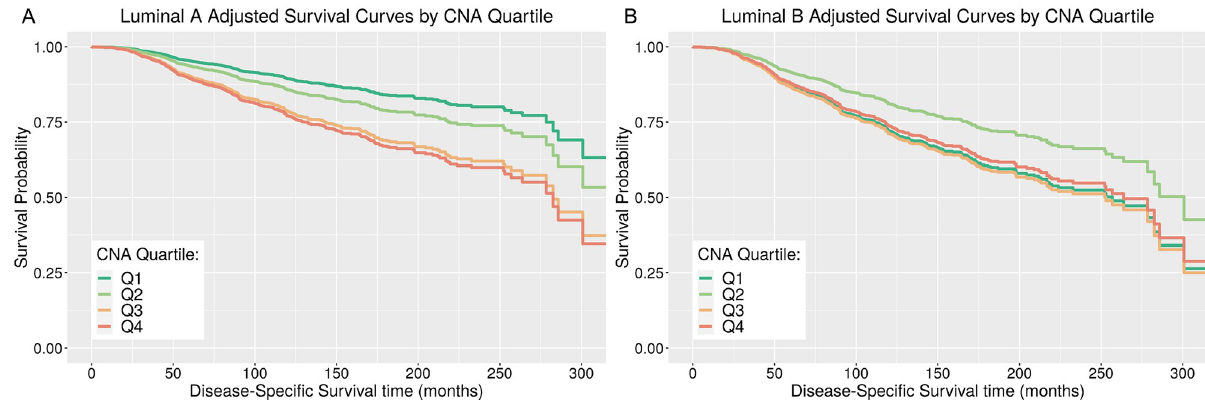
Fig 4. Adjusted survival curves for estimated CNA Quartile effects within each luminal PAM50 subtype. Adjusted survival curves for estimated CNA Quartile effects for METABRIC luminal A, Fig (A) and luminal B, Fig (B) breast cancer patients. Survival curves represent the estimated effect of CNA Quartiles, by plotting the predicted survival curves for luminal A and luminal B patients for each CNA Quartile, having adjusted for the effects of other covariates in the multivariable Cox model, where other covariates are fixed at the median/mode values of those variables.